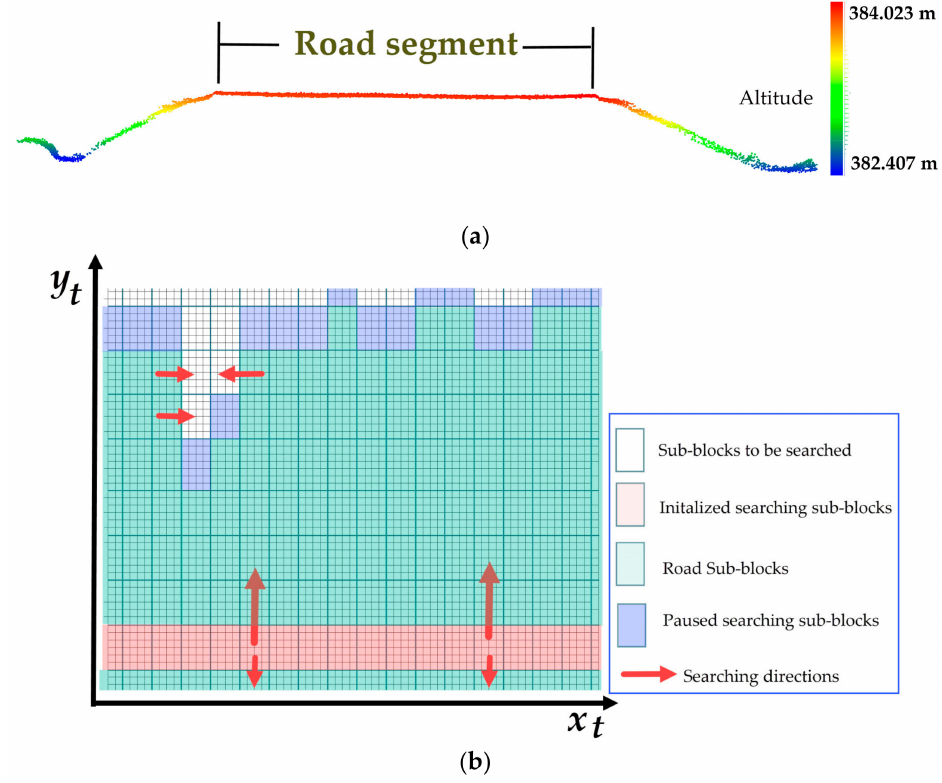
Figure 5. Detection of road surface and boundary area in Tgrid. ( a ) The cross-section of a road segment, and ( b ) the searching process of a road boundary area.